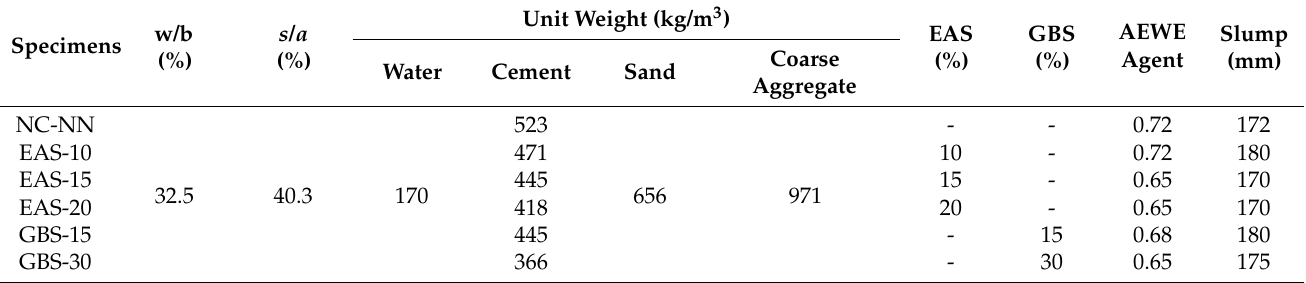
Table 1. Mixture proportions of